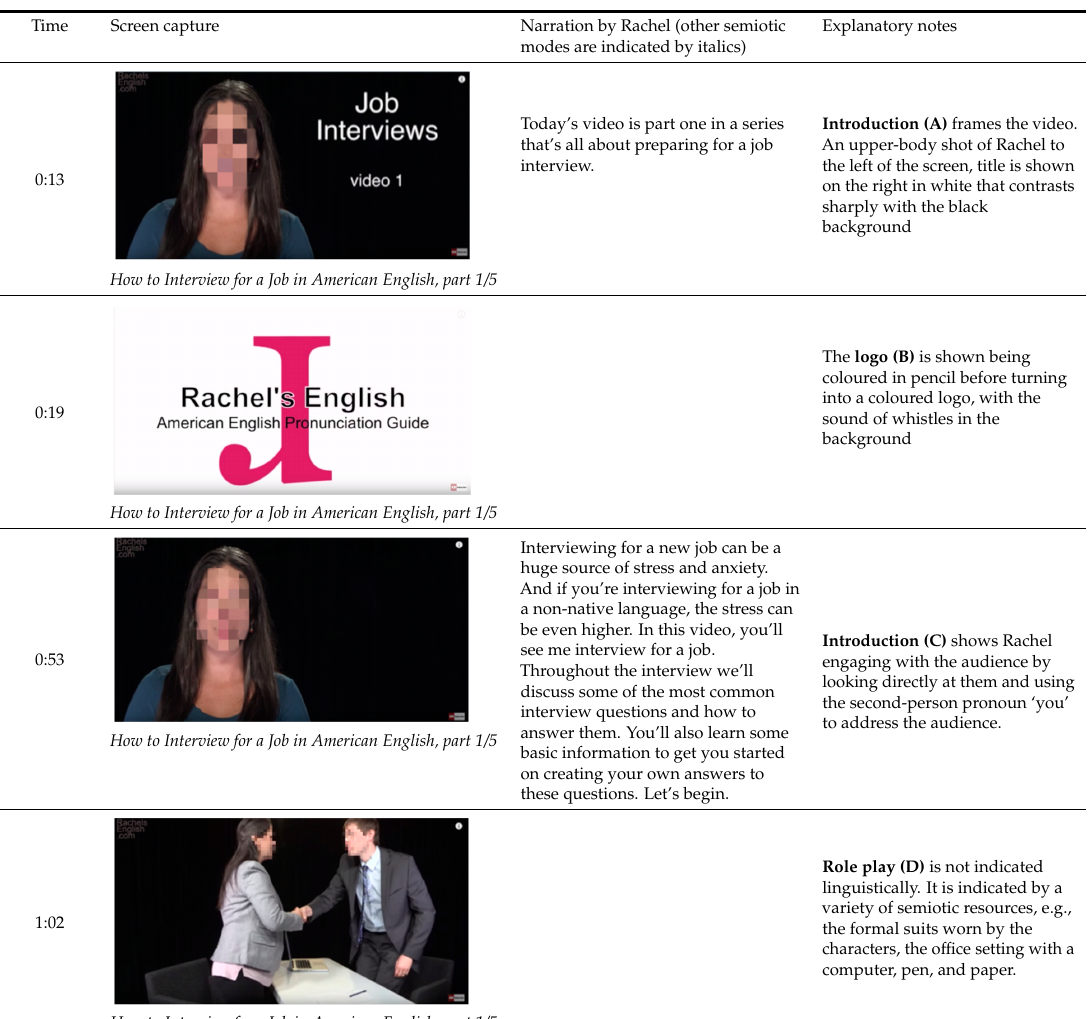
Table 3. A multimodal view of the lesson.